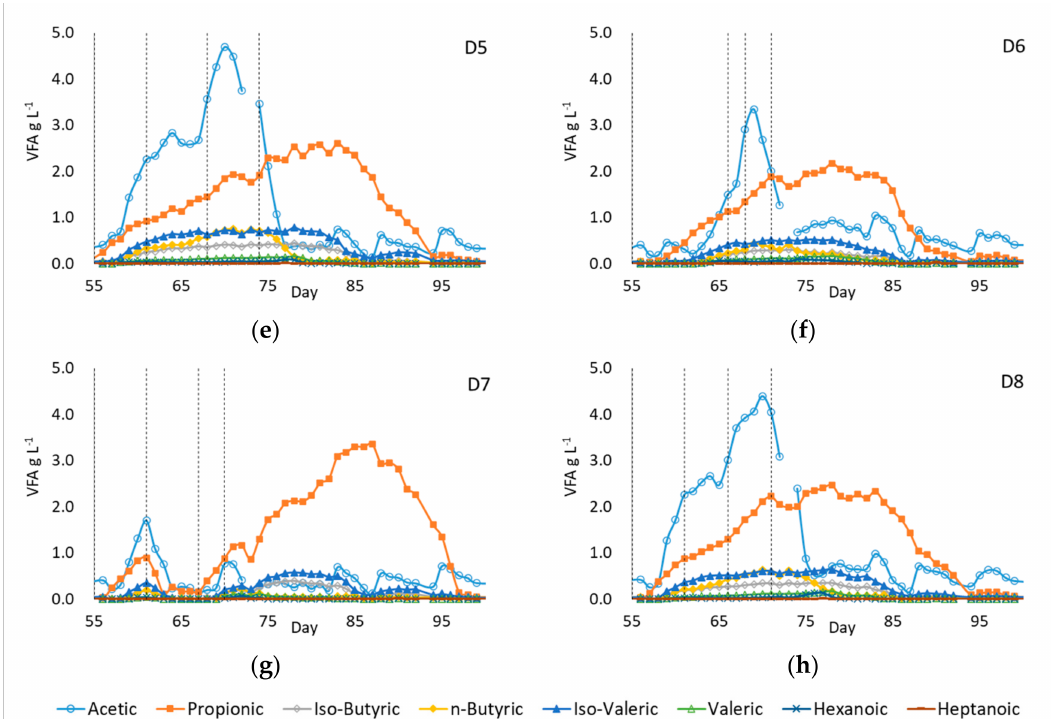
Figure 4. ( a – h ) VFA profiles between day 55 − 100 in digesters D1 − 8. All digesters initially received H 2 from day 55: vertical dotted lines indicate the start and end of subsequent periods of H 2 addition in each digester. Note the difference in y -axis scales for D1 − 4 and D5 −